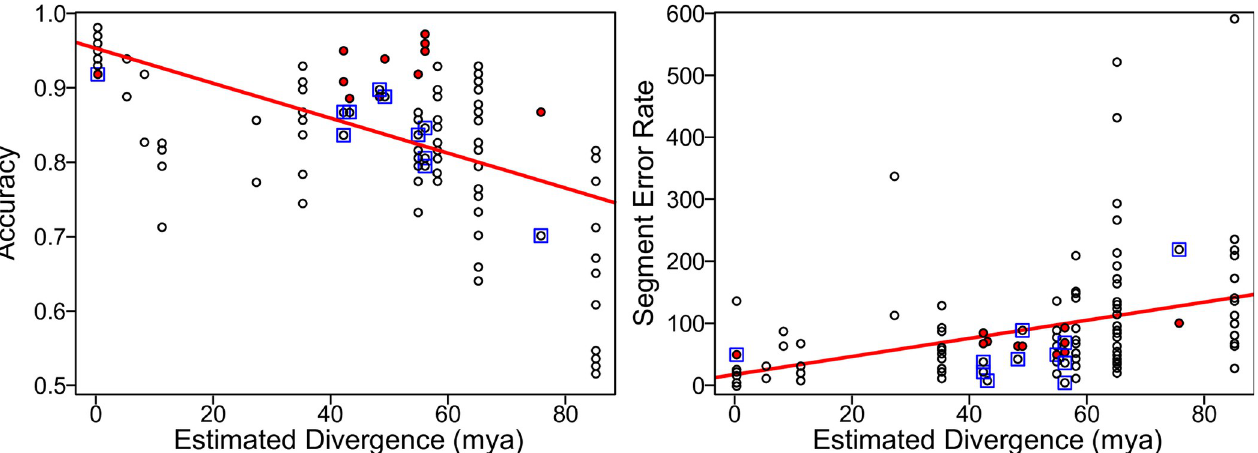
Fig 5. Model performance by species drops with estimated divergence, but training on multiple species performs better than expected given average divergence time. X-axis gives the estimated divergence time. Y-axis gives the accuracy (left) or segment error rate (right). Hollow black points show single- species models. Filled red points show multiple-species models. Blue square outlines show models where the test dataset was all species simultaneously. Red line shows the overall line of best fit (see S1 and S2 Figs in S1 File for individual species).